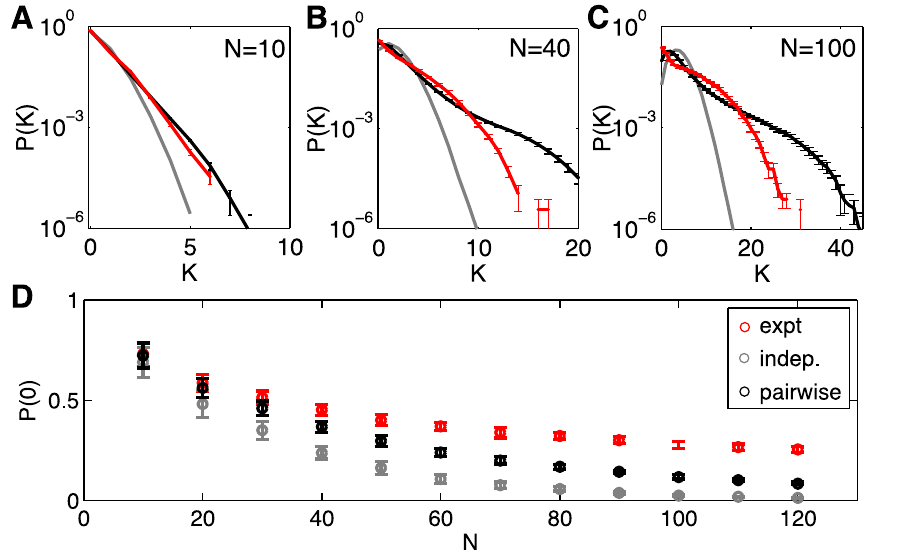
Figure 5. Predicted vs measured probability of K simultaneous spikes (spike synchrony). ( A–C ) P N ( K ) for subnetworks of size N ~ 10,40,100 ; error bars are s.d. across random halves of the duration of the experiment. For N =10 we already see large deviations from an independent model, but these are captured by the pairwise model. At N =40 (B), the pairwise models miss the tail of the distribution, where P ( K ) v 10 { 3 . At N =100 (C), the deviations between the pairwise model and the data are more substantial. ( D ) The probability of silence in the network, as a function of population size; error bars are s.d. across 30 subgroups of a given size N . Throughout, red shows the data, grey the independent model, and black the pairwise model.